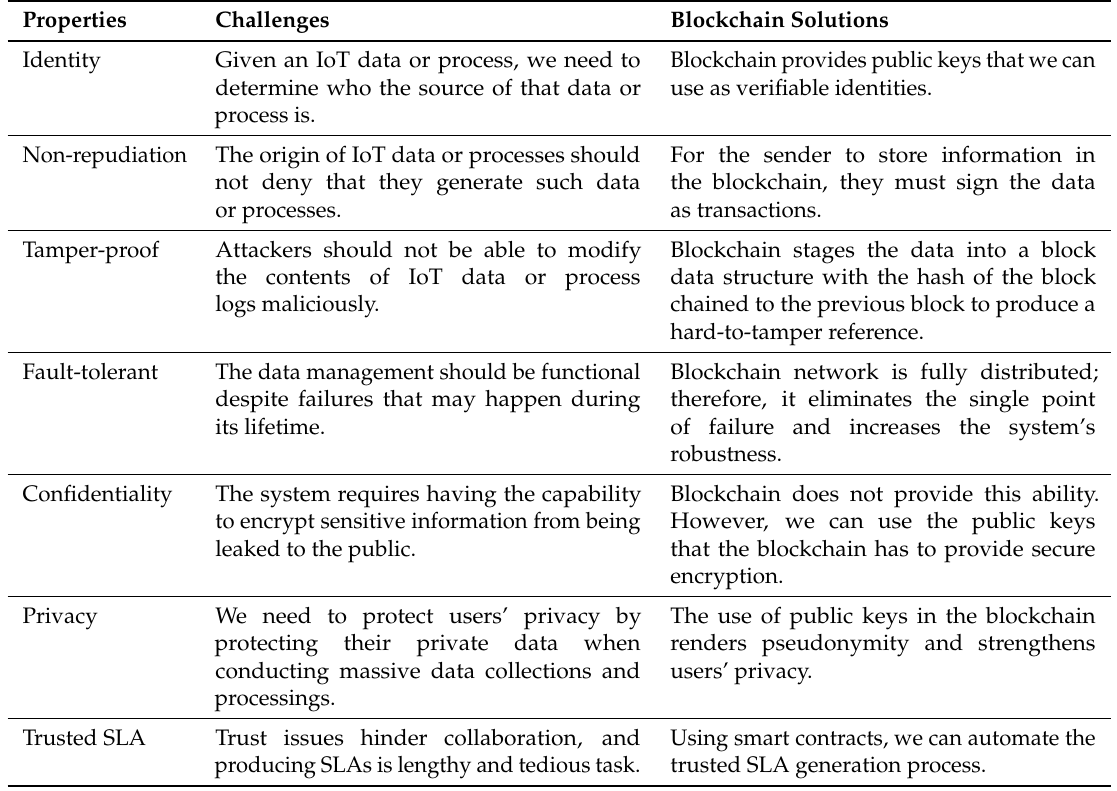
Table 1. Basic requirements for the management of the IoT data flow